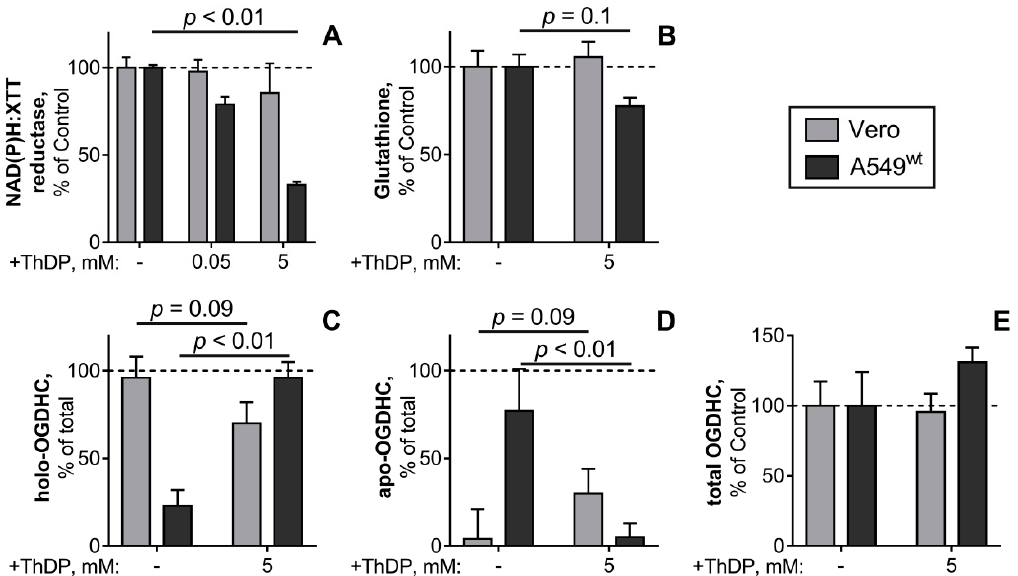
Figure 6. The ThDP-induced changes in the levels of NAD(P)H:XTT reductase activity ( A ), glutathione ( B ), OGDHC partition into the holo- ( C ) and apoenzymes ( D ) and total activity of OGDHC ( E ) of the cell lines Vero (grey bars) or A549 wt (black bars). The cells were cultured in standard DMEM, which was exchanged for the media with the indicated ThDP concentration (0–5 mM) 24 h before the assay of cellular NAD(P)H:XTT reductase activity or cell lysis for the glutathione and OGDHC assays. The data of at least three independent experiments are presented as means ± SEM. In A, B and D the % changes in cellular parameters are calculated relative to the values inherent in the same cells (A549 wt or Vero) under control conditions (100%). The absolute values for the glutathione levels and OGDHC activities, taken as 100%, are given in Table 2. In C and D, the percentage of the holo- and apo-OGDHC is calculated relative to the total OGDHC activity in each of the settings, as described in the text regarding the data in Figure 1. Statistical significance of the changes in a cell line was determined by one-way ANOVA followed by Tukey’s post hoc test for multiple groups (A) or by Mann-Whitney test for two groups (B-E), with p-values presented on the graphs.